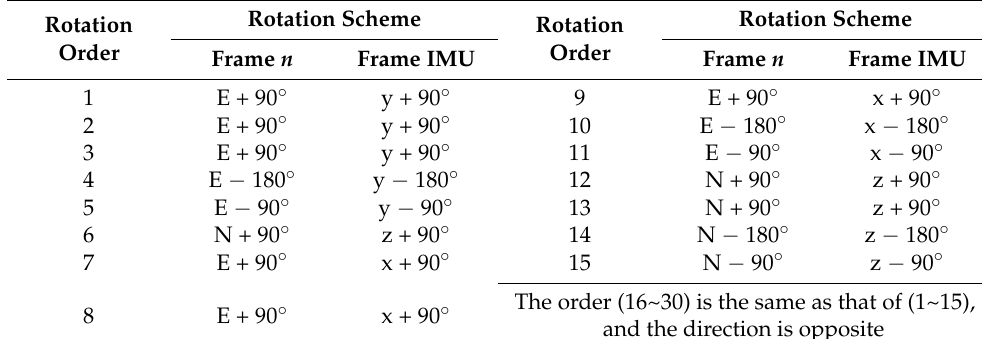
Table 1. 30-position rotation